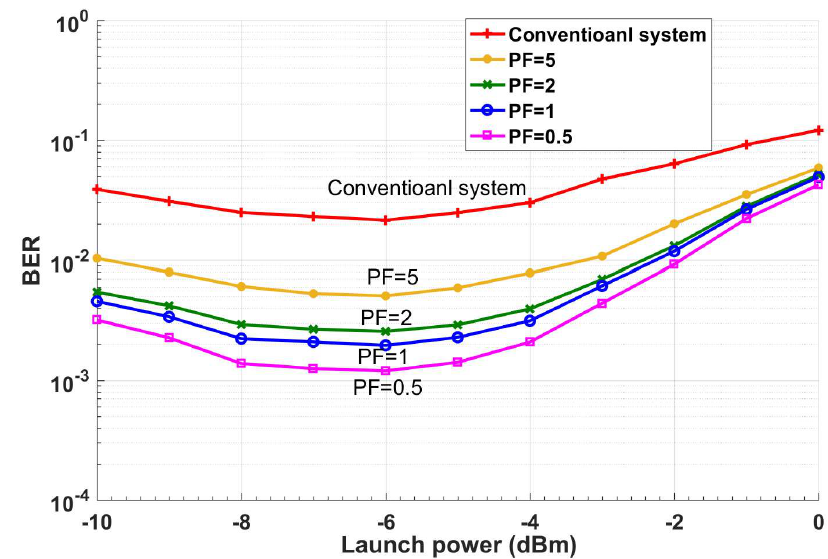
Figure 11. The simulation of BER improvement for various precision factor (data rate = 52 Gb/s and transmission distance, L = 1600 km).